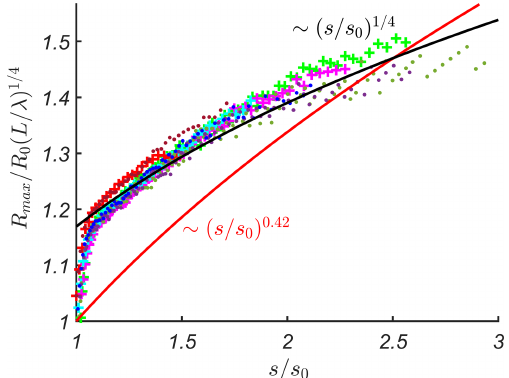
Figure 11. The normalized maximum run-up height, R max /R 0 ( L/λ ) 1 / 4 , calculated numerically versus the wave front steepness, s/s 0 , for the same values of A/h 0 and kh 0 as in Fig. 10. Red solid line is proportional to the “analytically estimated” Eq. (16), while black solid line corresponds to Eq.